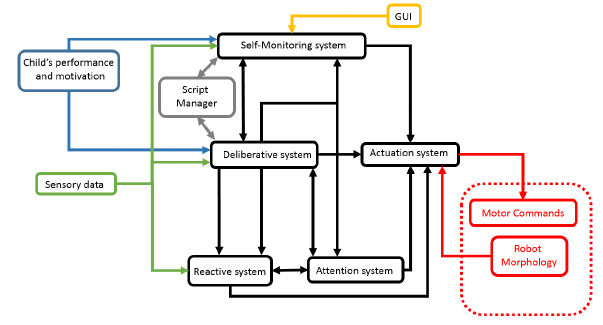
Figure 10: Description of the cognitive controller subsystems and how information flows from one subsystem to another.